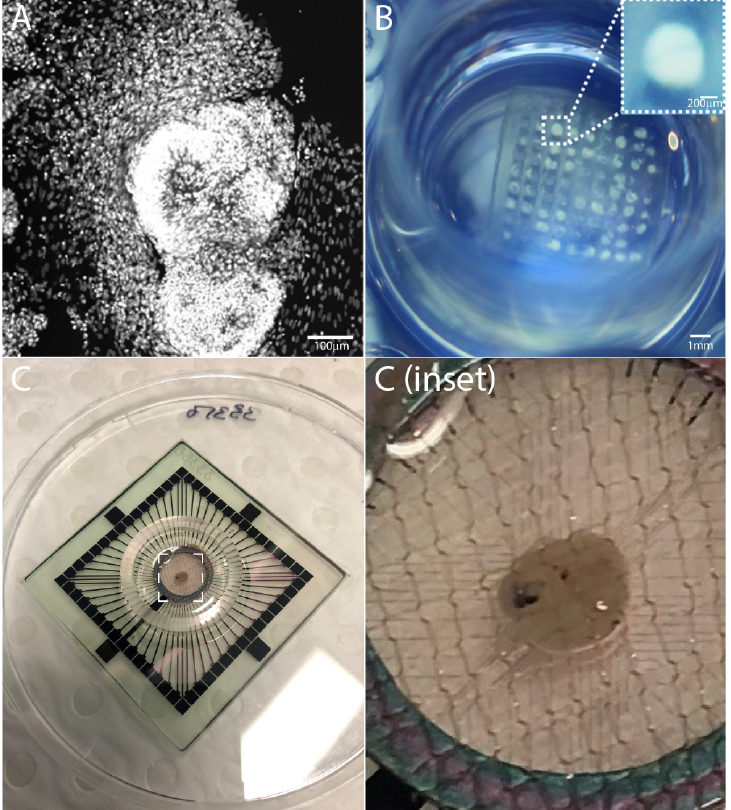
Figure 1. Human iPSC-derived human brain organoids, ( A ) comprising complex cellular and regional heterogeneity, ( B ) generated in large numbers using 3D-printed hydrogel arrays, and ( C ) placed on a microelectrode array (MEA) for extracellular electrophysiological recordings